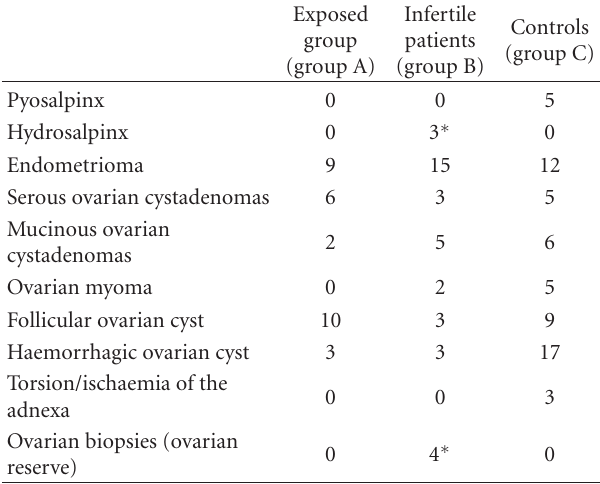
Table 2: Histopathological diagnosis on excised